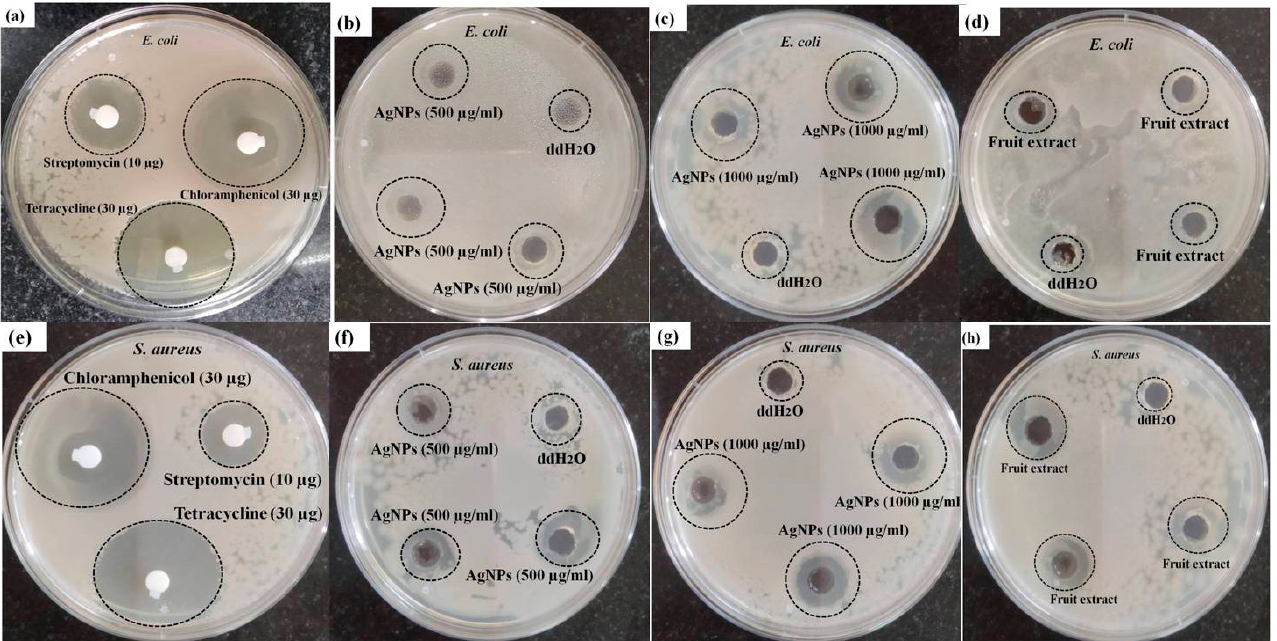
Figure 9. Antibacterial activities of ( a , e ) antibiotics (streptomycin(10 µg), Chloramphenicol (30 µg) and Tetracycline (30 µg)) as positive control, ( b , f ) synthesized AgNPs (500 µg/mL),( c , g ) synthesized AgNPs (1000 µg/mL), ( d , h ) Diospyros malabarica aqueous fruit extracts (1000 µg/mL) and double distilled water (ddH 2 O) as negative control, on ( a ) Escherichia coli and ( b ) Staphylococcus aureus (all the experiments were performed in triplicates).